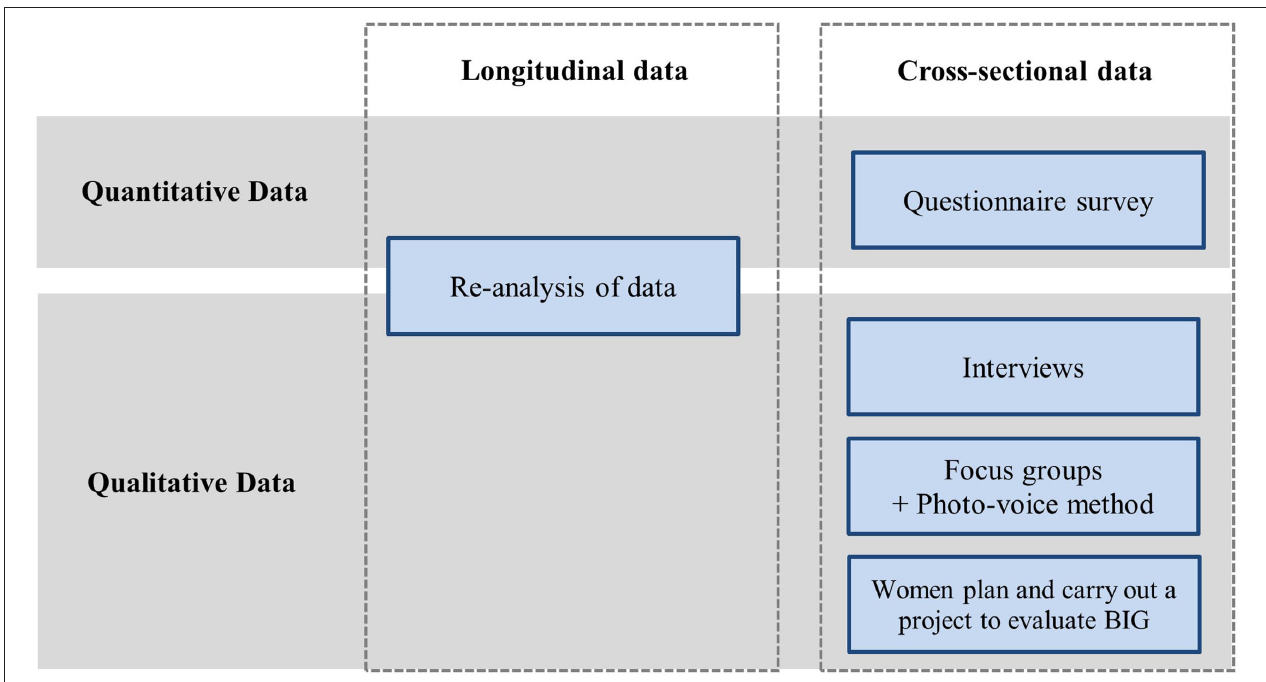
FIGURE 1 | Study design of